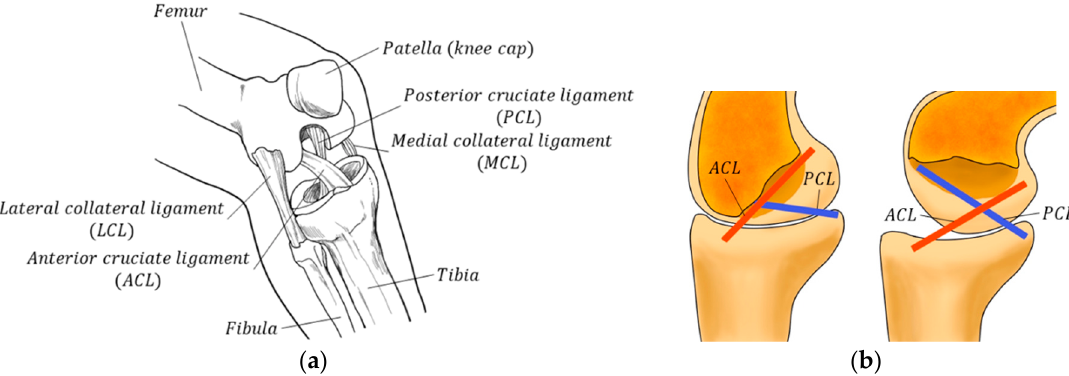
Figure 1. Overview of knee anatomy: ( a ) anatomical structure of the human knee; ( b ) changes in the shape and tension of the anterior cruciate ligament (ACL) and posterior cruciate ligament (PCL).